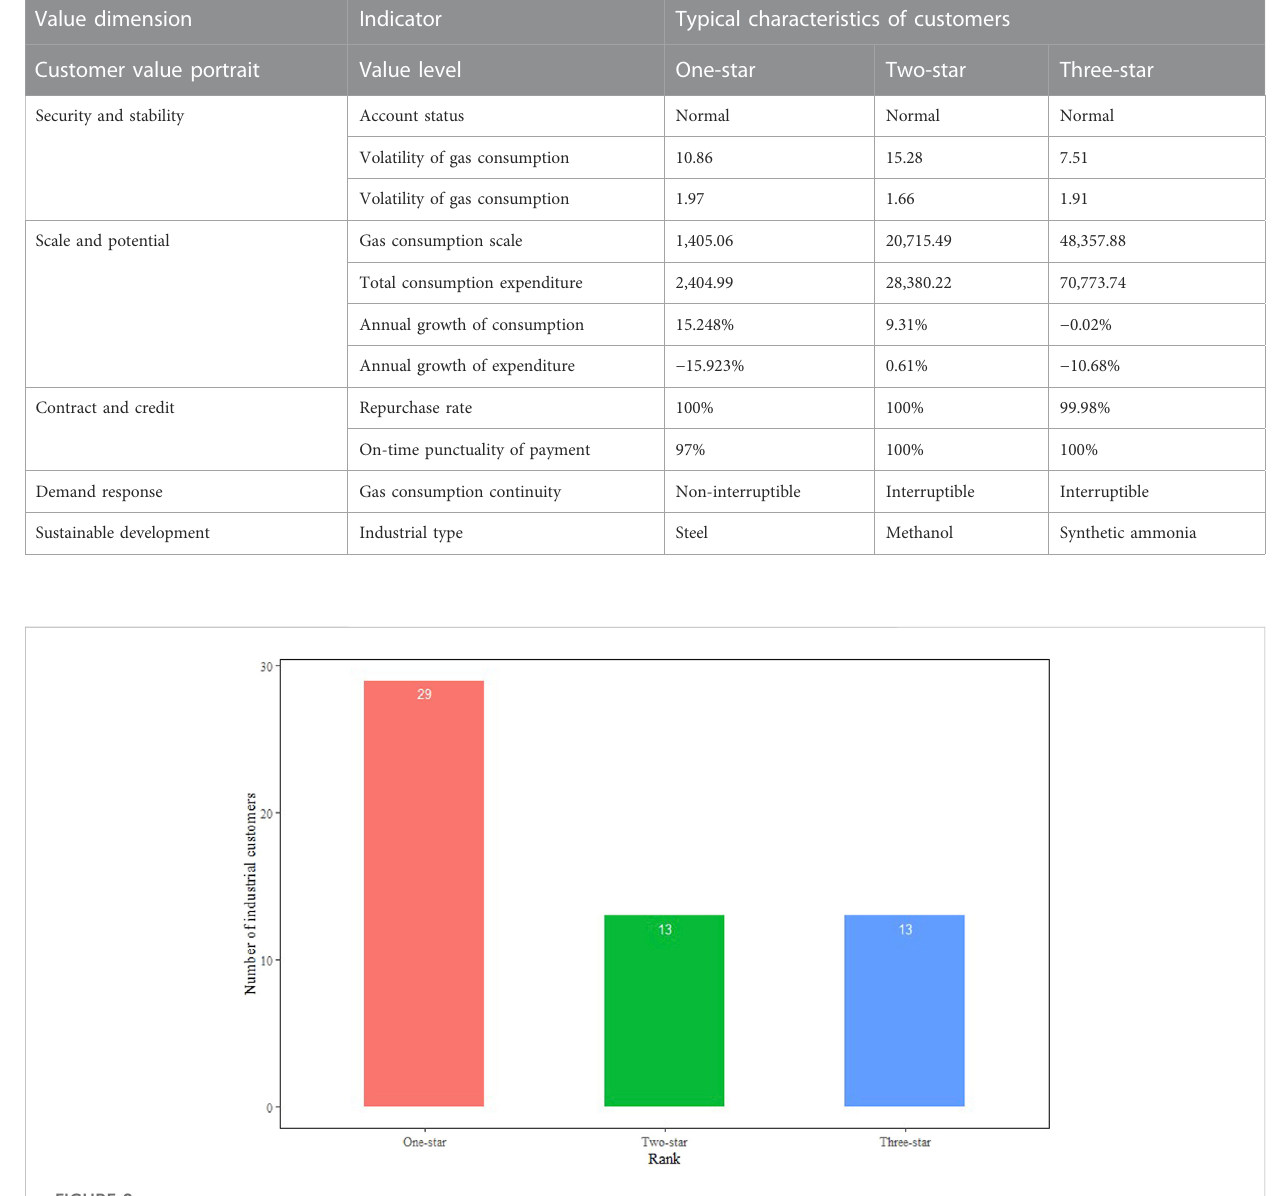
FIGURE 8 Number of natural gas customers by the value